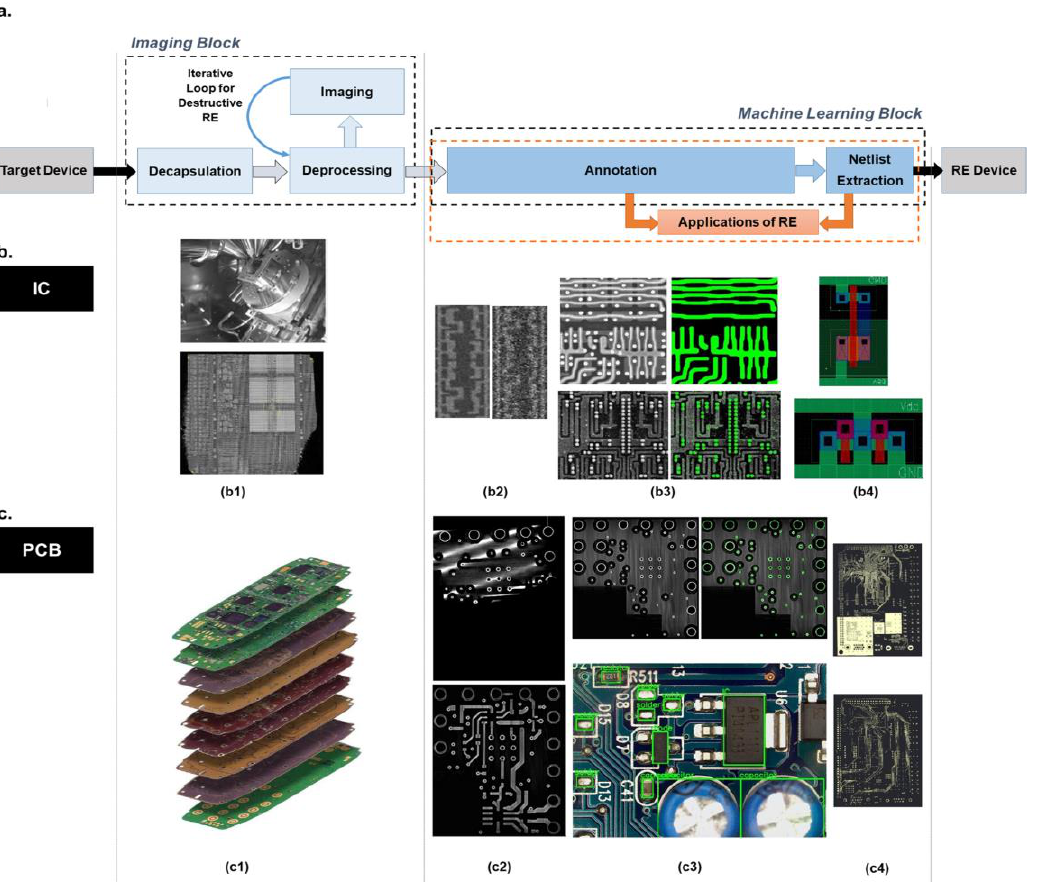
Figure 37. The systematic overview of a reverse engineering (RE) process, which can be performed on ICs and printed circuit boards (PCBs), its challenges and possibilities. ( a ) A typical workflow of RE encompassing various stages. Two main blocks of such a workflow are: Image Analysis and Machine Learning. The outputs of the machine learning-related block can enable us to provide hardware-based trust and assurance, as an application of reverse engineering. ( b ) reverse engineering workflow for IC: ( b1 ) deprocessing of the IC, ( b2 ) example of noise removal in the active region using different imaging parameters, ( b3 ) segmentation and extraction of polysilicon structures and vias in an IC, ( b4 ) netlist of extracted logic cells. ( c ) Reverse engineering workflow for PCB: ( c1 ) image depicting a multi-layered PCB. Depending on the number of the layers in a PCB, different types of reverse engineering techniques should be considered. Irrespective of this, these challenges are inevitable, ( c2 ) example for misaligned layer and reconstructed image, ( c3 ) segmentation and extraction of vias for X-rayed PCB and labelled components on the surface of an optically imaged PCB, ( c4 ) segmented layout of PCB layers with connected and not-connected vias [119]. Abbreviations used: RE, Reverse Engineering. Reprinted with permission from ref. [119]. 2021 Association for Computing Machinery.